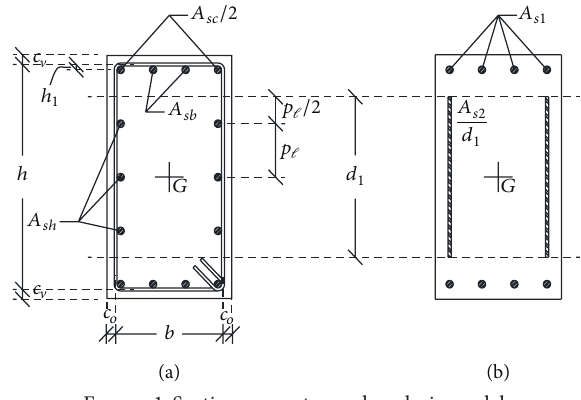
Figure 1: Section geometry and analysis model.